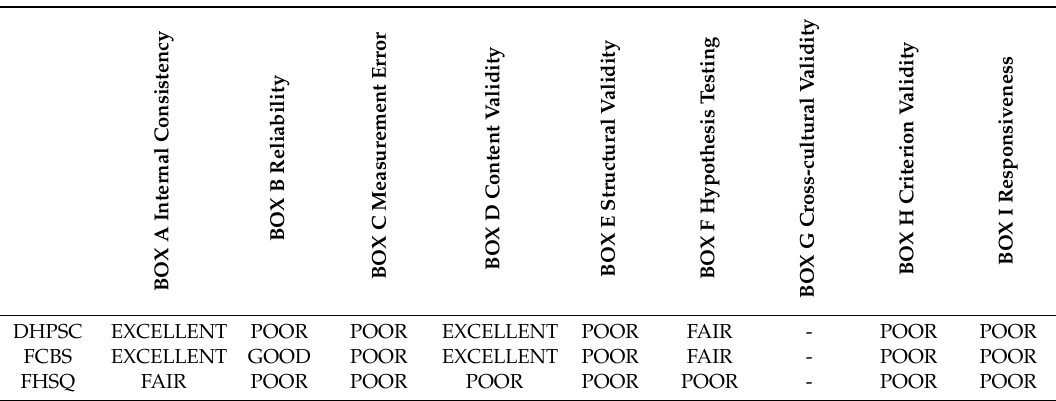
Table 5. Methodological quality scores per patient-reported outcome measures (PROMs) on a measurement